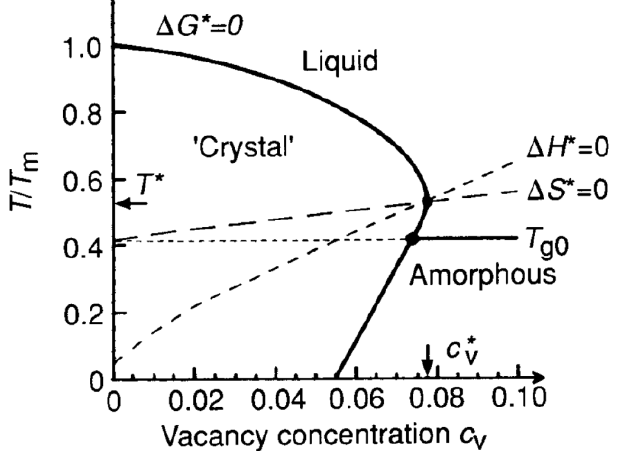
Figure 8. Reproduced Figure 2 of Ref. [45]. Universal melting diagram representing three nonequilibrium states: the crystal supersauterated with vacancies, the undercooled liquid and the amorphous solid. Additionally, included as a function of the respective crystal defect concentrations, C v , are the (crystal-liquid) isentropic (Δ S * = 0) and isenthalpic temperatures (Δ H * = 0) which cross the melting line (Δ G * = 0) at the melting instability ( T * , C v*